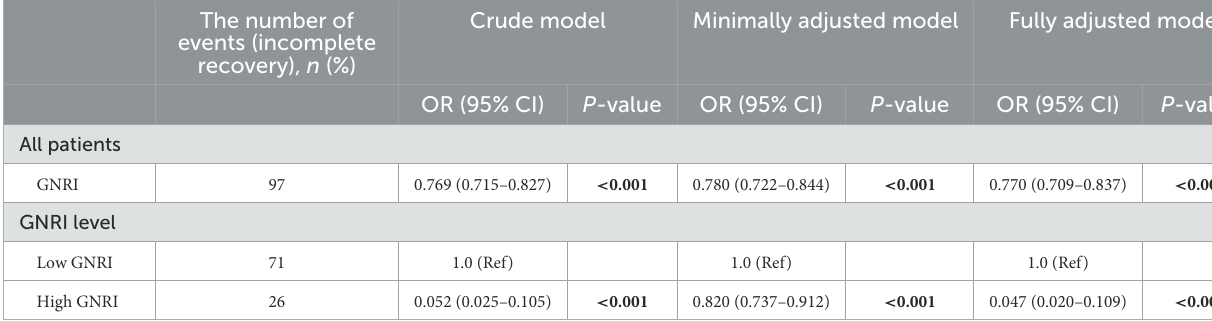
TABLE 3 Association between the baseline GNRI and the risk of incomplete recovery.